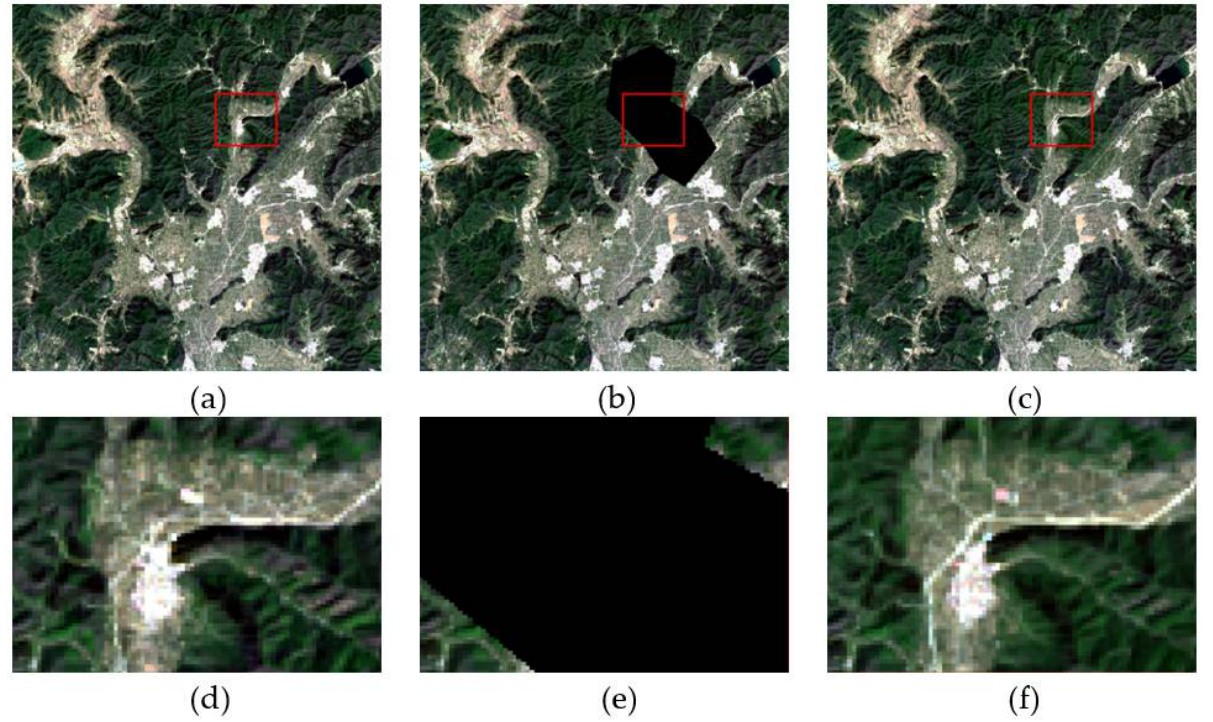
Figure 13. The simulated experiment with a missing area of 6.01%: ( a ) original image; ( b ) simulated cloudy image; ( c ) reconstructed image; ( d – f ) enhanced details from red boxes in ( a – c